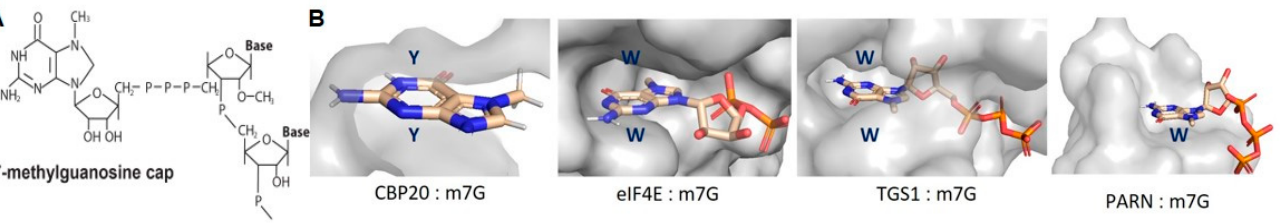
Figure 3. Structural basis for 7-methylguanosine (m 7 G) base recognition by cap-binding proteins. ( A ) (Transcription start site of nascent RNAPII transcripts experience 5 ′ -5 ′ linkage to guanosine that is methylated at the N 7 position to form the m 7 G-cap. ( B ) Space-filling models present the conserved m 7 G-cap binding pockets of: CBP20 of the CBP20/CBP80 heterodimer; cytoplasmic cap binding protein, eIF4E; trimethylguanosine synthase, TGS1; poly(A)-specific ribonuclease, PARN.